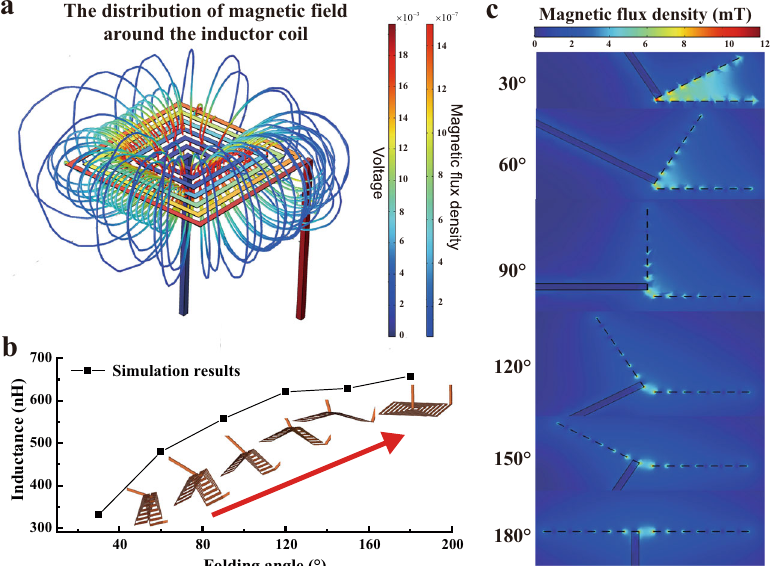
Fig. 3 The sensing simulation of PSIFS. a Simulation results of the voltage and magnetic line distribution. b Variation curve of inductance values in different states. c Magnetic fl ux density distribution in different